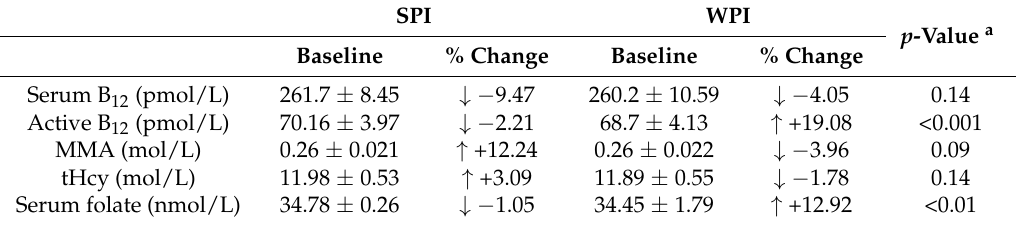
Figure 2. Mean change scores and 95% Confidence Intervals for Treatment × Gender interactions for Delta ( A ) Reasoning Speed and ( B ) Reaction Time. ** p < 0.01. Table 4. Baseline scores (Mean ± SE) and percentage change observed due to treatment.